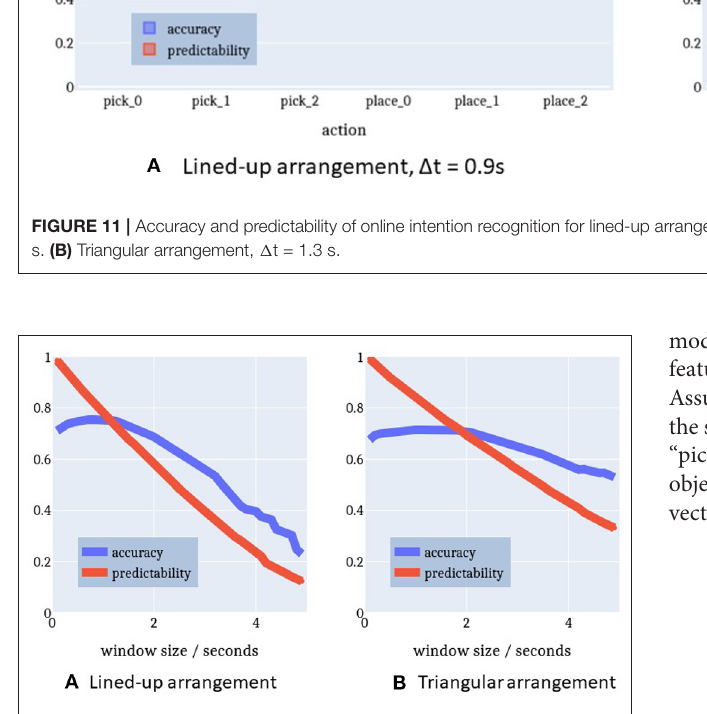
FIGURE 12 | Relationship between time window (min = 0.1 s, max = 5 s) and performance measures. Time window and performance are inversely proportional to each other. A maximum accuracy for a reasonable predictability is reached at time window 1 t = 0.9s for the lined-up arrangement and 1 t = 1.3s for the triangle arrangement, respectively. (A) Lined-up arrangement. (B) Triangular